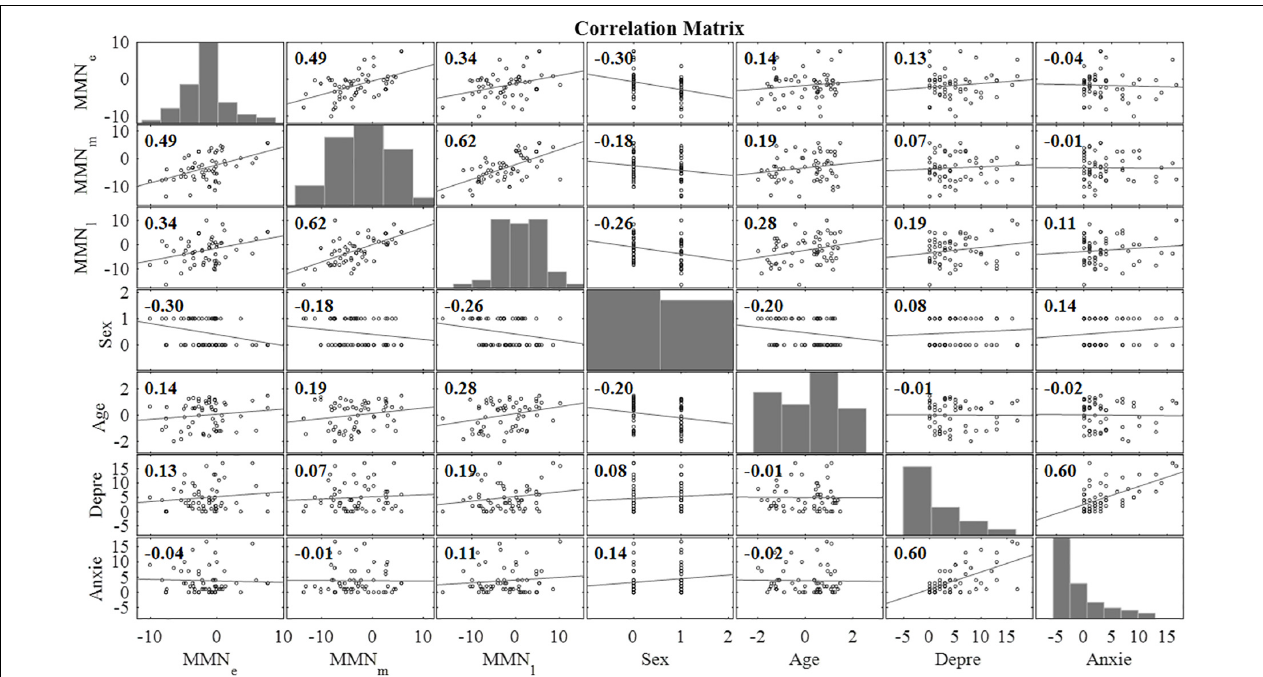
FIGURE 4 | Correlation matrix for the main variables of interest ( n = 58). MMN e = mean mismatch response value (over all emotional categories) in early time window (80–120 ms), MMN m = mean mismatch response value (over all emotional categories) in intermediate time window (240–280 ms), MMN l = mean mismatch response value (over all emotional categories) in late time window (350–450 ms), Sex = the sex of the child, Age = the age of the child at the measurement (months), Depre = the maternal depression symptoms assessed with EPDS at gestational week 24, Anxie = the maternal anxiety symptoms assessed with SCL-90 at gestational week 24.